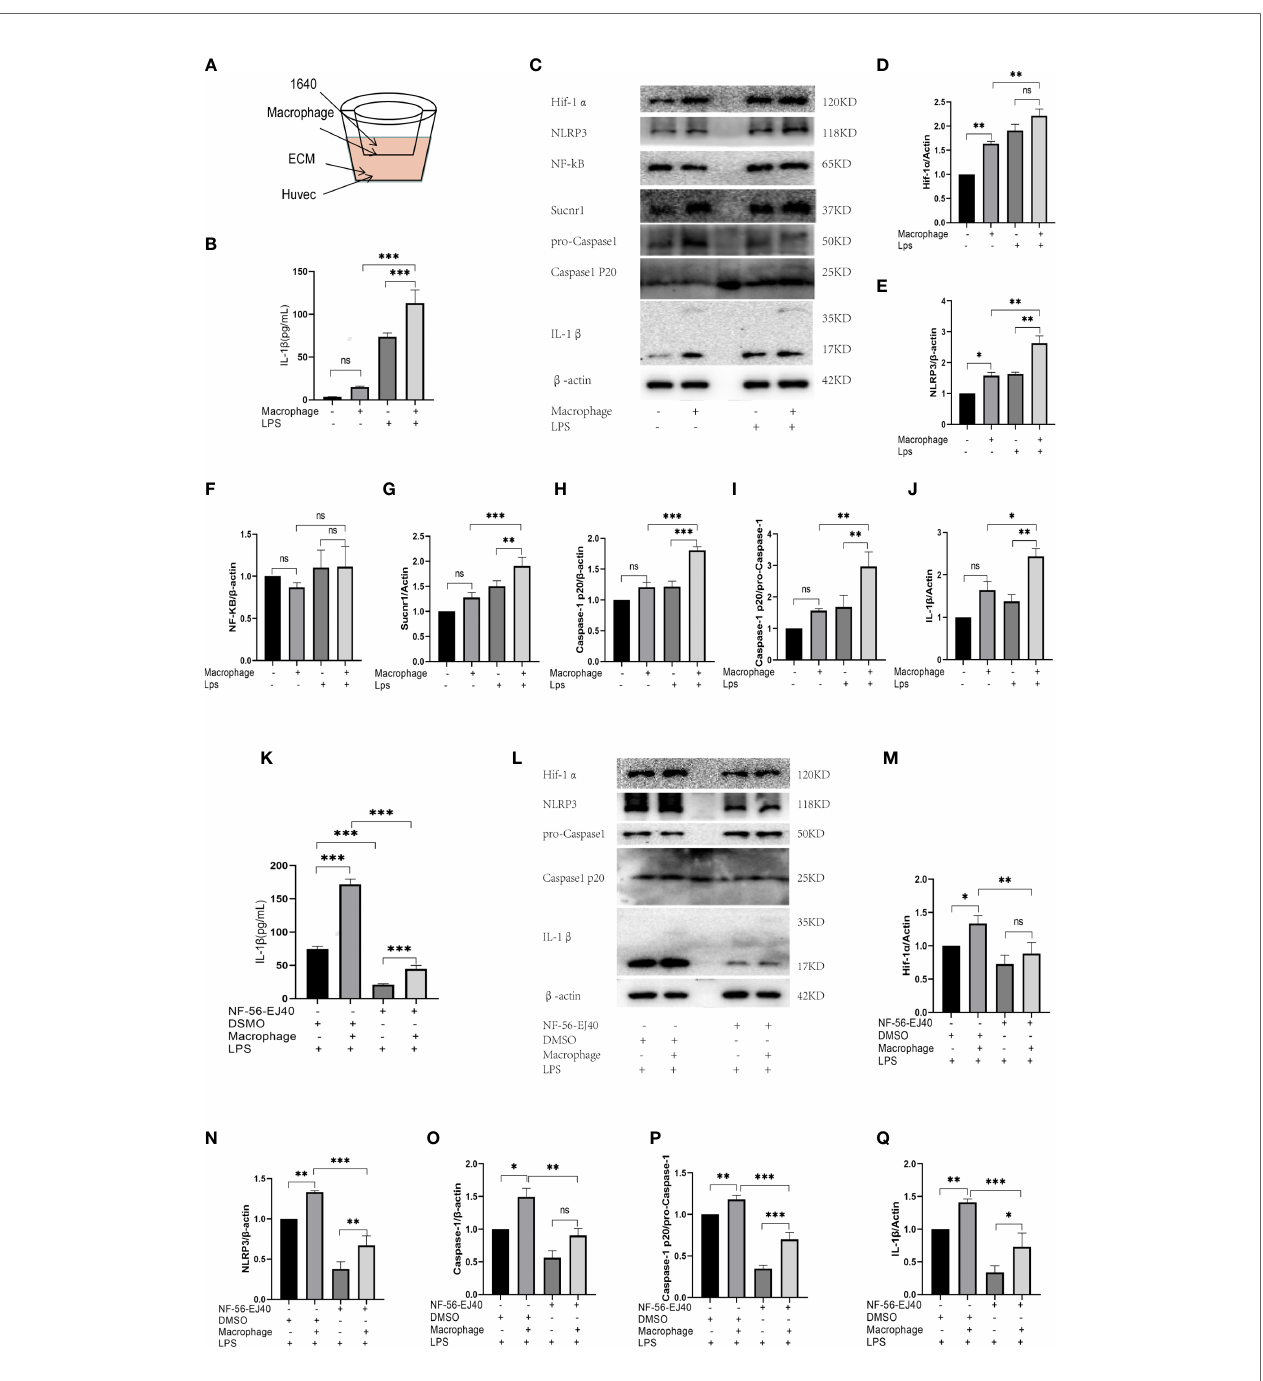
FIGURE 7 | The expression of succinate/IL-1 b signal axis during coculture system. (A) HUVECs were cocultured with macrophages in Transwell system, as shown in the fi gure. HUVECs were seeded in the down plate with 2.5 ml ECM complete medium, and macrophages were seeded in the upper fi brous membranes with 1.6 ml RPMI-1640 complete medium. The groupings of the coculture system were designed as follows: HUVECs with coculture medium (ECM and RPMI-1640), HUVECs cocultured with macrophages, HUVECs with coculture medium and LPS, HUVECs cocultured with macrophages and LPS, then the supernatant medium and holoprotein of HUVECs were extracted. (B) IL-1 b of supernatant medium was detected via ELISA. (C – J) Expression levels of succinate/IL-1 b signal axis and NF- k B were tested via Western blots. NF-56-EJ40 tried to rescue the in fl ammatory response of coculture system, and HUVECs were grouped as follows: I: LPS stimulated; II: cocultured with macrophages and LPS stimulated; III: NF-56-EJ40 inhibited and LPS stimulated; IV: NF-56-EJ40 inhibited, cocultured with macrophages, and LPS stimulated. Similarly, the supernatant medium and holoprotein of HUVECs were extracted. (K) IL-1 b of supernatant medium was detected via ELISA. (L – Q) Expression levels of succinate/IL- 1 b signal axis and NF- k B were tested via Western blots. Western blot data present mean ± SEM from three independent experiments at least. ELISA results represent mean ± SD from three different experiments at least. * P < 0.05; ** P < 0.01; *** P < 0.001; ns means no statistical